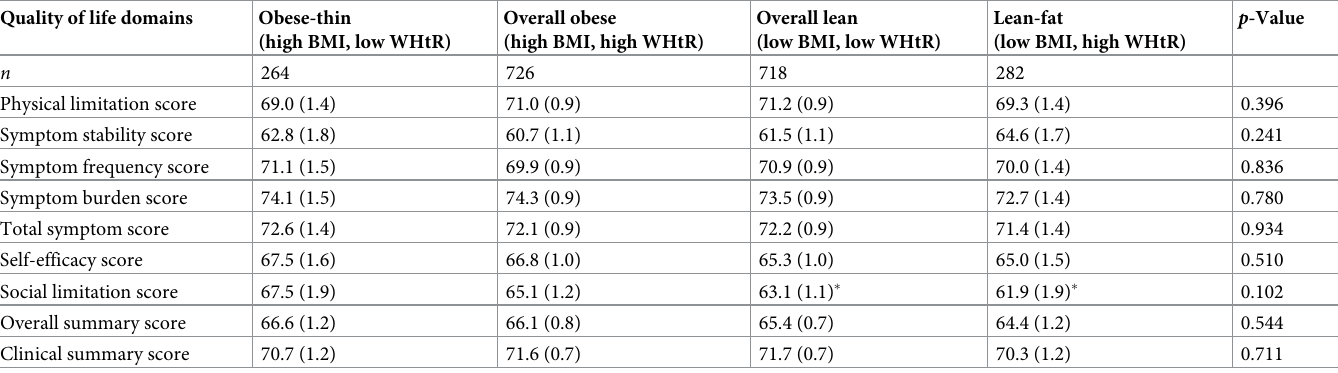
Table 3. Adjusted mean Kansas City Cardiomyopathy Questionnaire domain scores, by BMI/WHtR group. Quality of life domains Obese-thin (high BMI, low